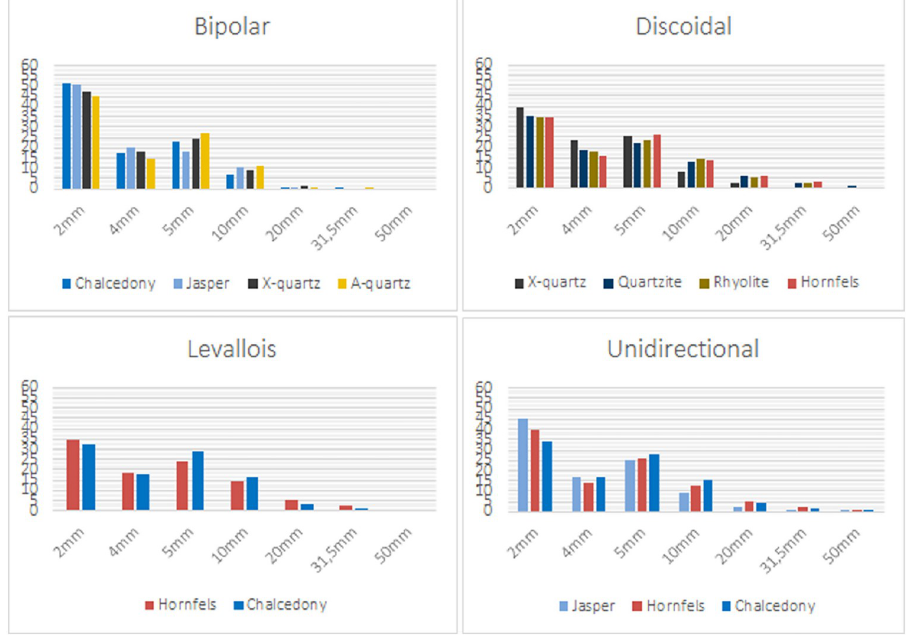
Fig 5. Histograms comparing mean distributions of percentage of particles per size class